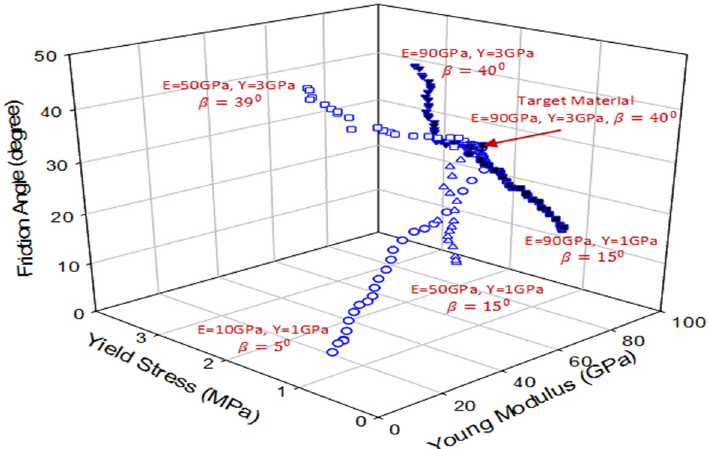
Figure 10. Converging trends of five initial guess values using S&B dual indenter for pressure-sensitive plastic material properties.